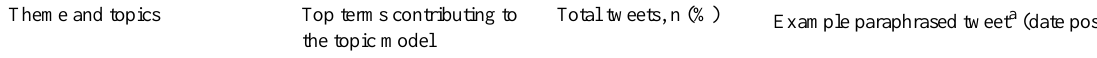
Table 1. Numbers and percentages of tweets related to each COVID-19 vaccine topic